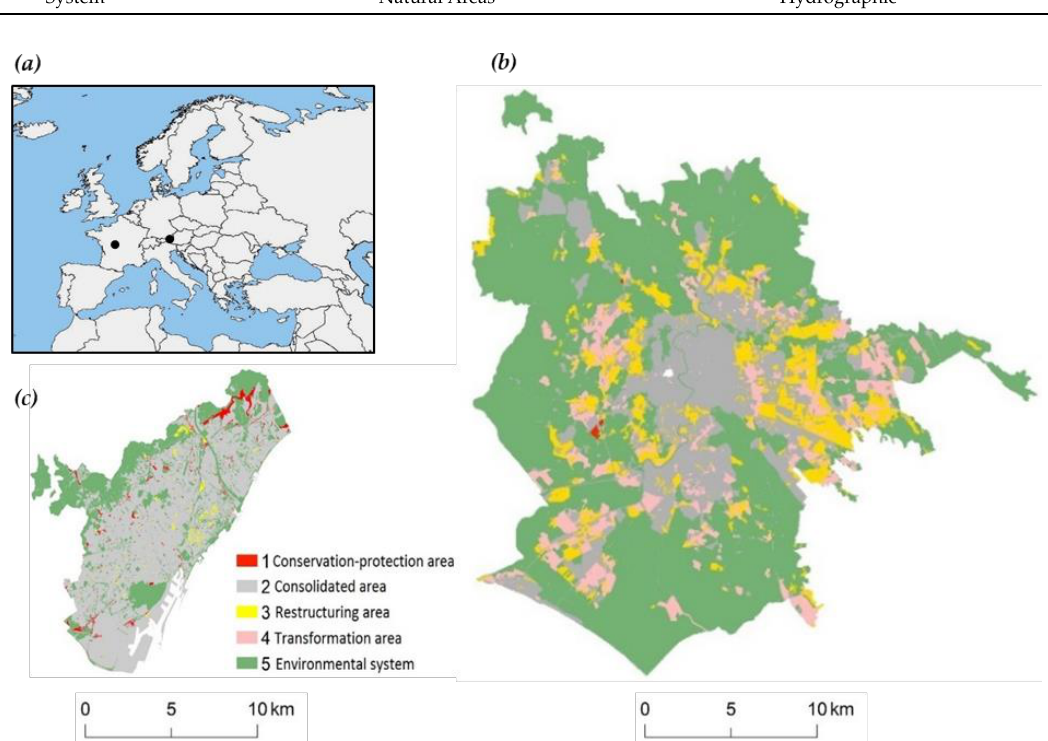
Figure 2. ( a ) Geographical location of the two cities of Rome in Italy and Barcelona in Spain (black dots); Spatial distribution of zoning classes 1 – 5 (see Table 1) based on the strategic plans for ( b ) Rome and ( c ) Barcelona .